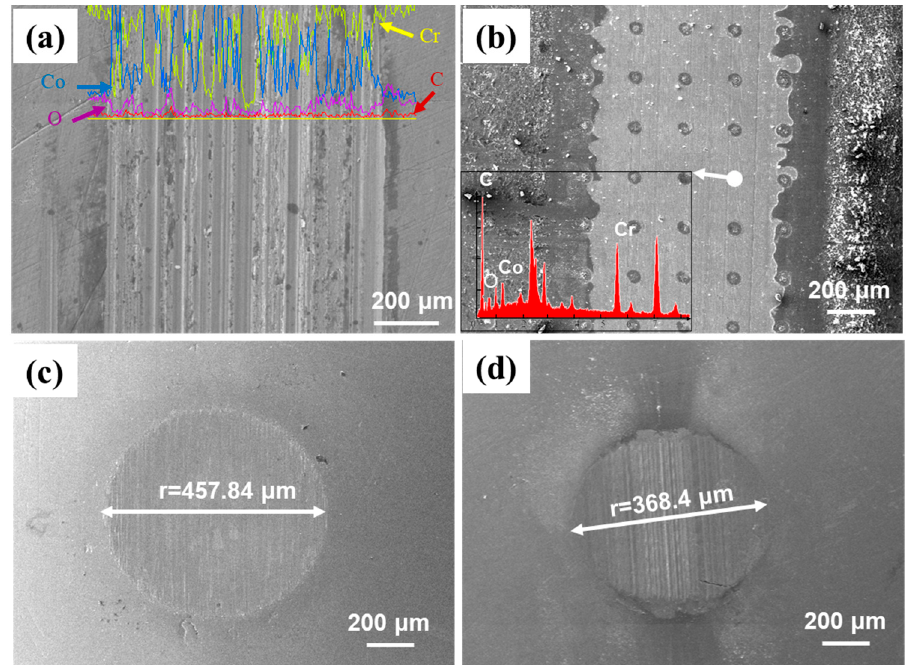
Figure 8. SEM micrographs of the lower disk samples and their corresponding upper ball samples: ( a , c ) flat CoCrMo sample and its upper pin and ( b , d ) Co–T–S sample and its upper pin. The inserted